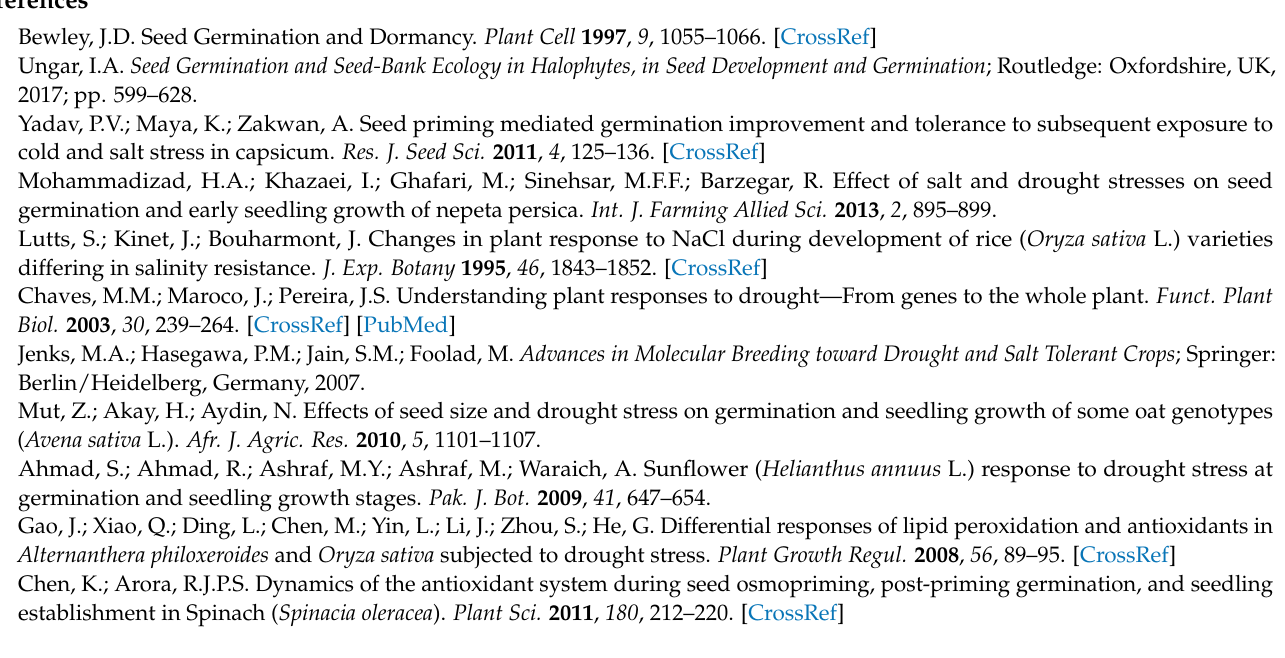
Figure S3: Enriched KEGG pathways of differential expressed genes during the three adjacent stages. Figure S4: Analysis of differentially abundant proteins in phenylpropanoid biosynthe- sis. Figure S5: Analysis of differentially abundant proteins in plant-hormone signal transduction. Figure S6: Ontology diagram of hyperosmotic salinity response (GO:0042538). Figure S7: On- tology diagram of cellular response to water deprivation (GO:0042631). Figure S8: Clustering analyses of protein domain enrichment results of differentially abundant proteins. Figure S9: Clus- tering analyses of molecular function (MF) enrichment results of differentially abundant proteins. Figure S10: Clustering analyses of cellular component (CC) enrichment results of differentially abundant proteins. Figure S11: Heat map of differentially abundant proteins in the protein–protein interaction network (PPI). Table S1: The overview of proteome identification in T. hispida . Table S2: Enriched KEGG pathways of differential expressed genes (DEGs) and differentially abundant pro- teins (DAPs) during the three adjacent stages. Table S3: Protein abundance in phenylpropanoid biosynthesis. Table S4: Protein abundance in flavonoid biosynthesis. Table S5: Enriched GO pathways of differentially abundant proteins (DAPs) during the three stages. Table S6: Proteins that respond to water deprivation stress and hyperosmotic salinity